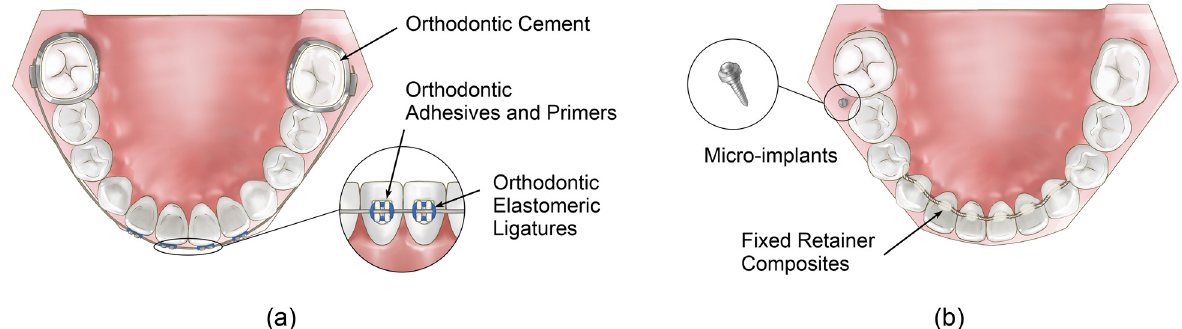
Figure 4: ( a and b ) Orthodontic